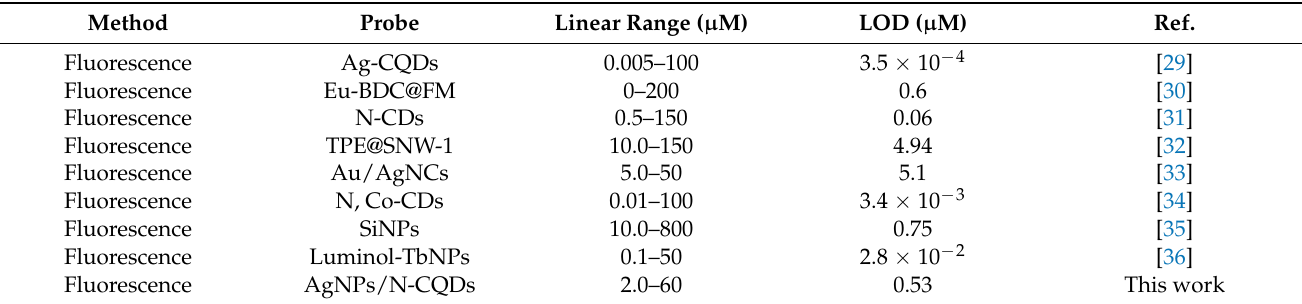
Table 1. Comparison of developed methods previously reported methods in terms of the response range and